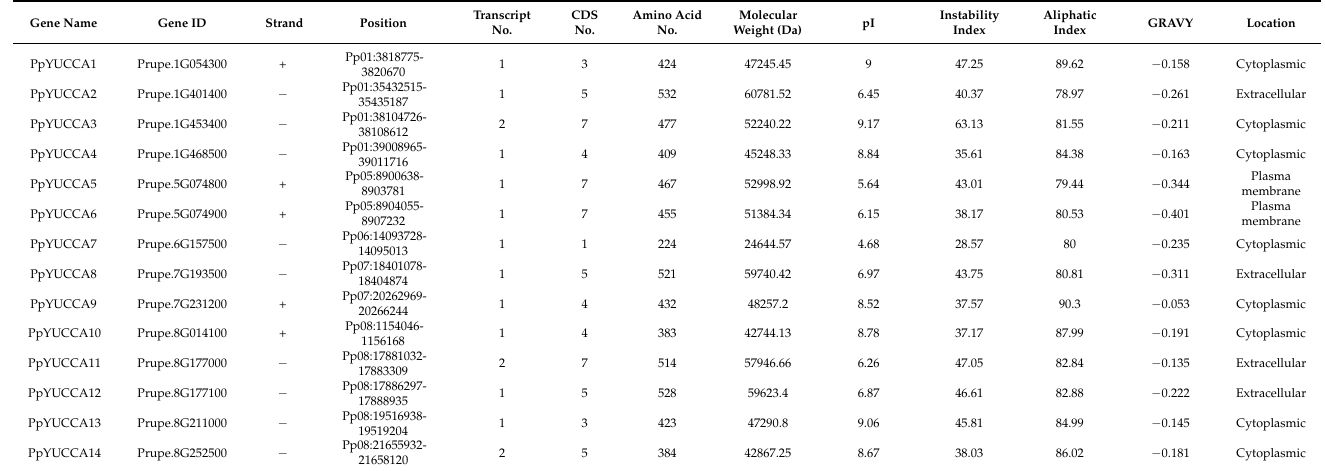
Table 1. Characteristics of the PpYUCCA gene family in peach trees.